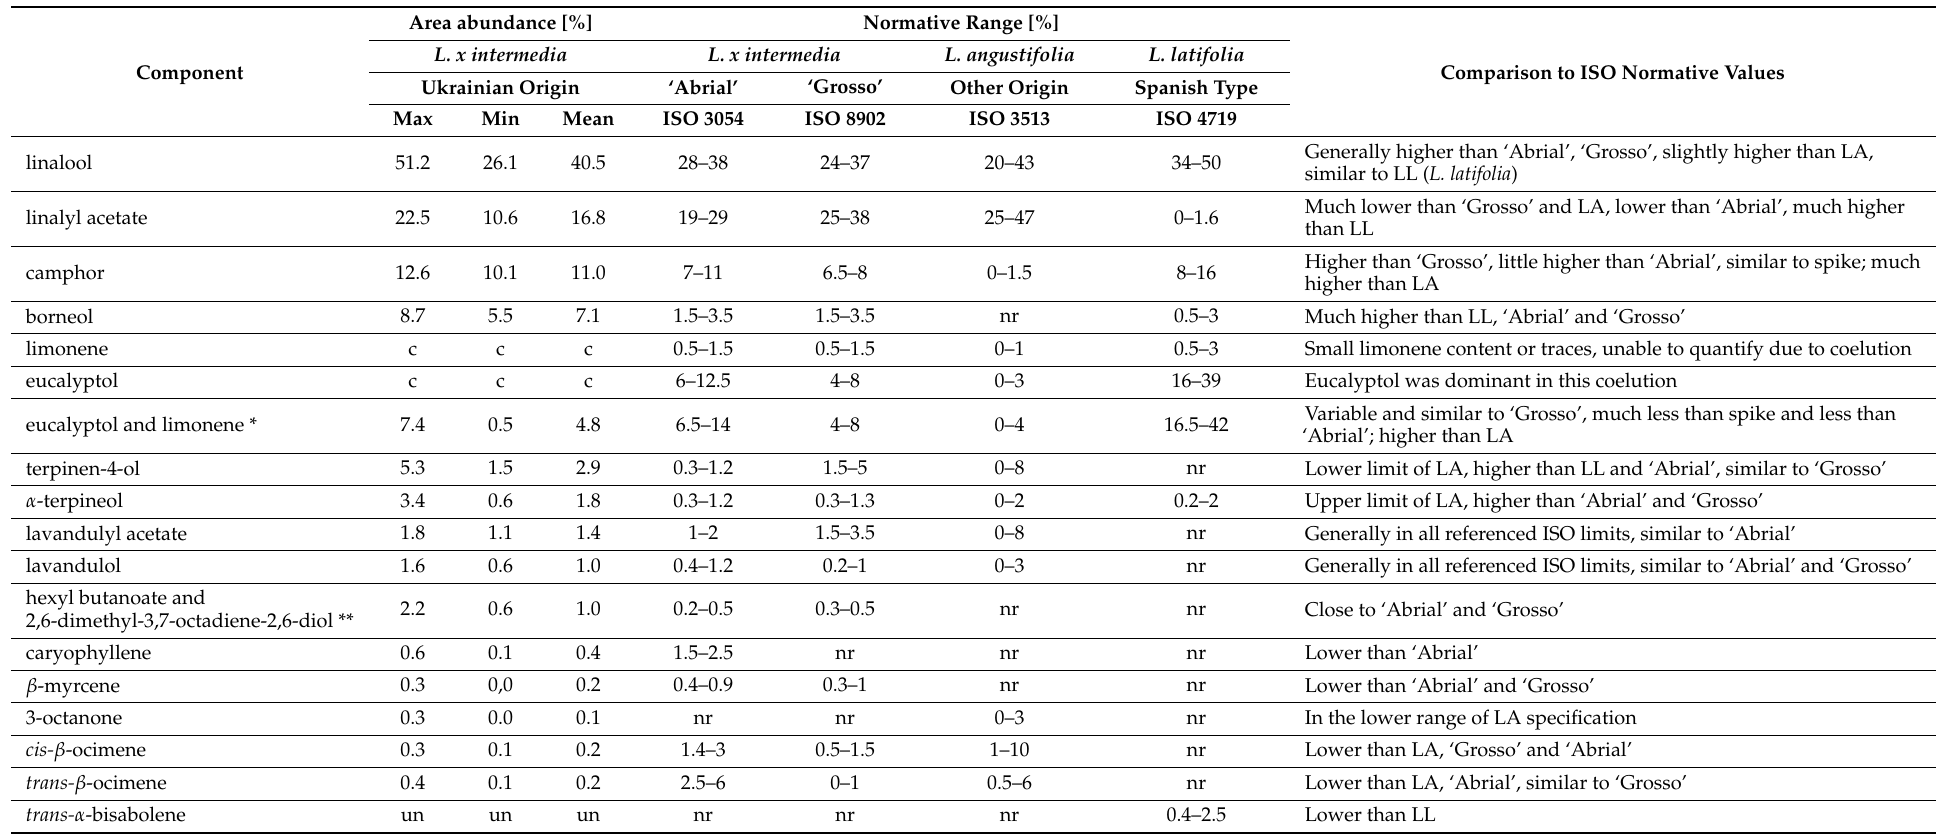
Table 6. Comparative table for the chemical composition of EOs obtained from new Ukrainian cultivar of L. x intermedia, with the normative content values given different ISO norms for L. x intermedia and its parent species L. angustifolia and L. latifolia